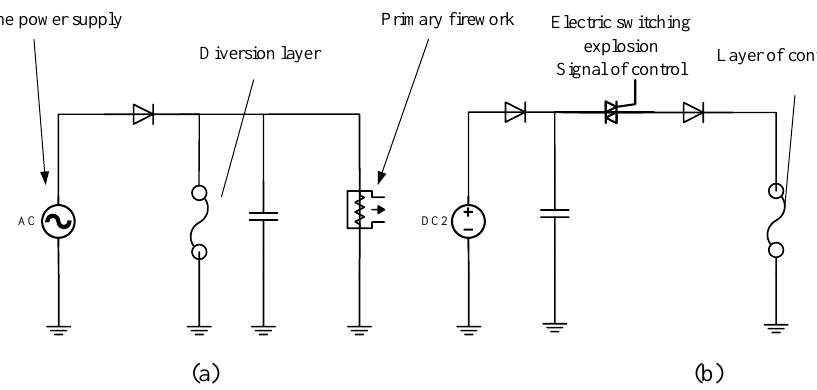
Figure 3. Circuit diagram of indirect electrical explosion action. ( a ) The control circuit of the explosive initiation, the diversion layer is in the normally open state. ( b ) Bridge section view of the solid-state ON – OFF.